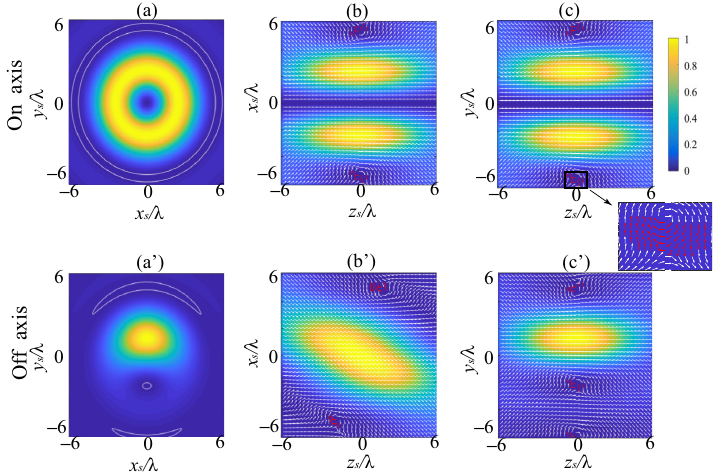
Figure 5. The longitudinal energy flow S z on the ( a , a’ ) xOy -plane, ( b , b’ ) xOz -plane and ( c , c’ ) yOz - plane. In ( a – c ) σ c = 1, a = 0, ( a’ – c’ ) σ c = 1, a = 0.5 w 0 . In all plots, f = 2 mm, w 0 = 2 mm and α = 60 ◦